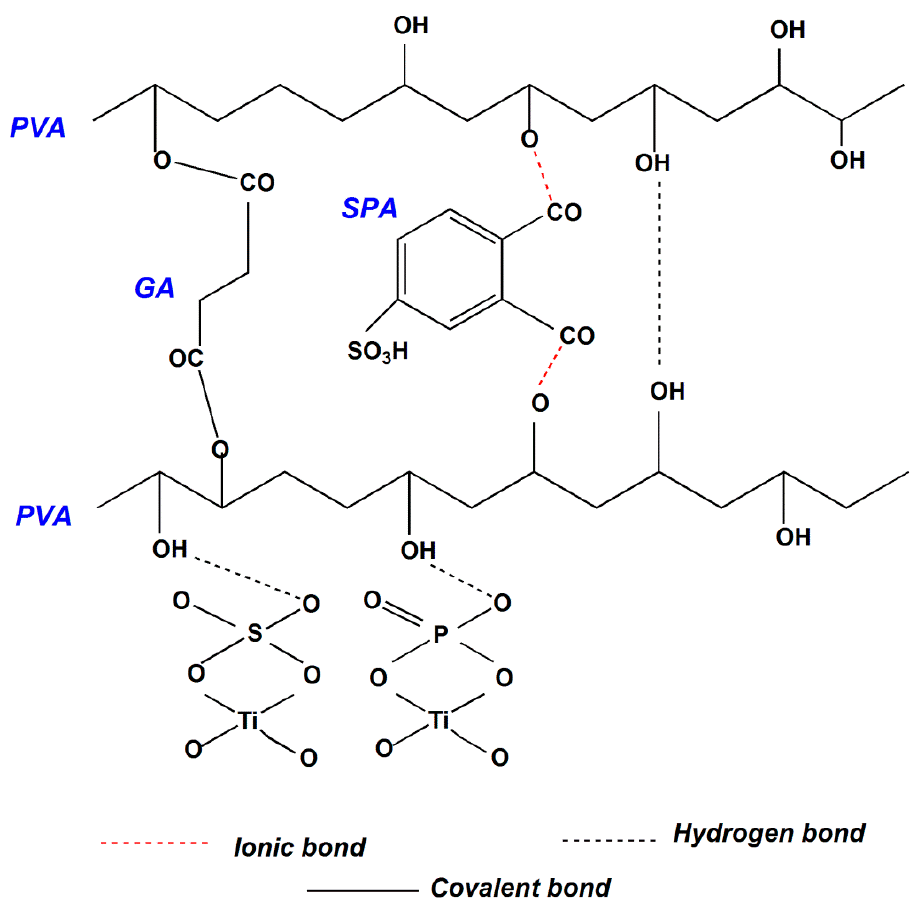
Figure 1. Possible interaction structure of the SPVA-SPTiO membrane cross-linked with SPA and GA.